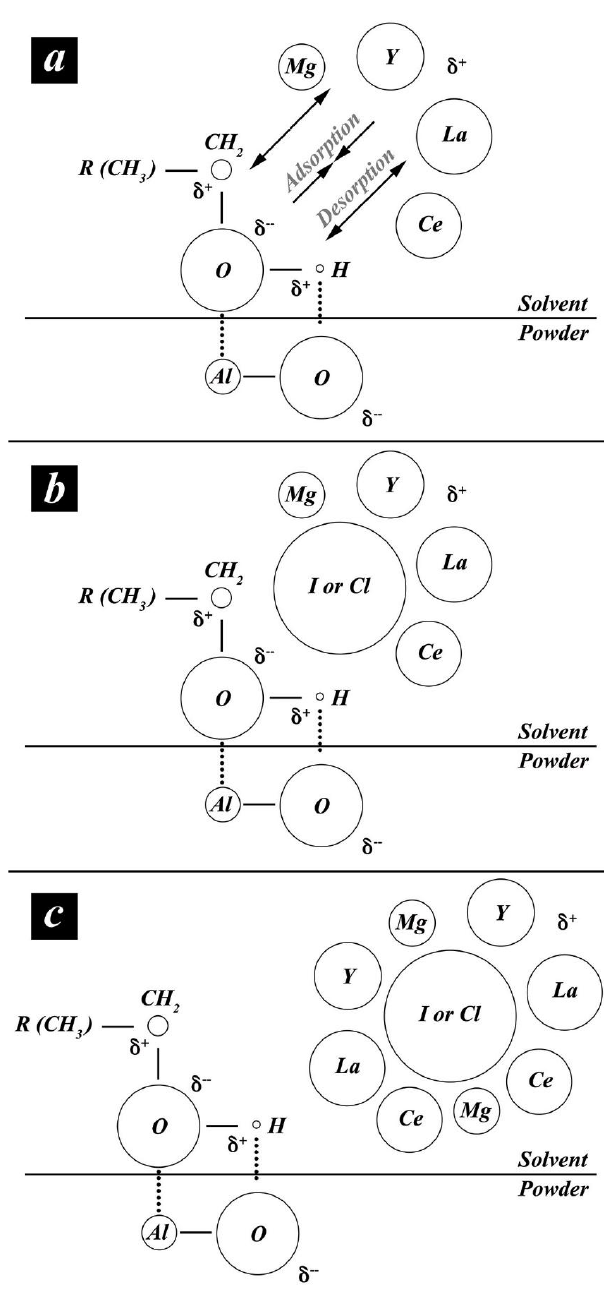
Fig. 3. A schematic representation of the alumina surface in etha- nol in present of iodine anions and solved cation salts. Iodine con- centration a) < critical concentration, b) = critical concentration and c) > critical